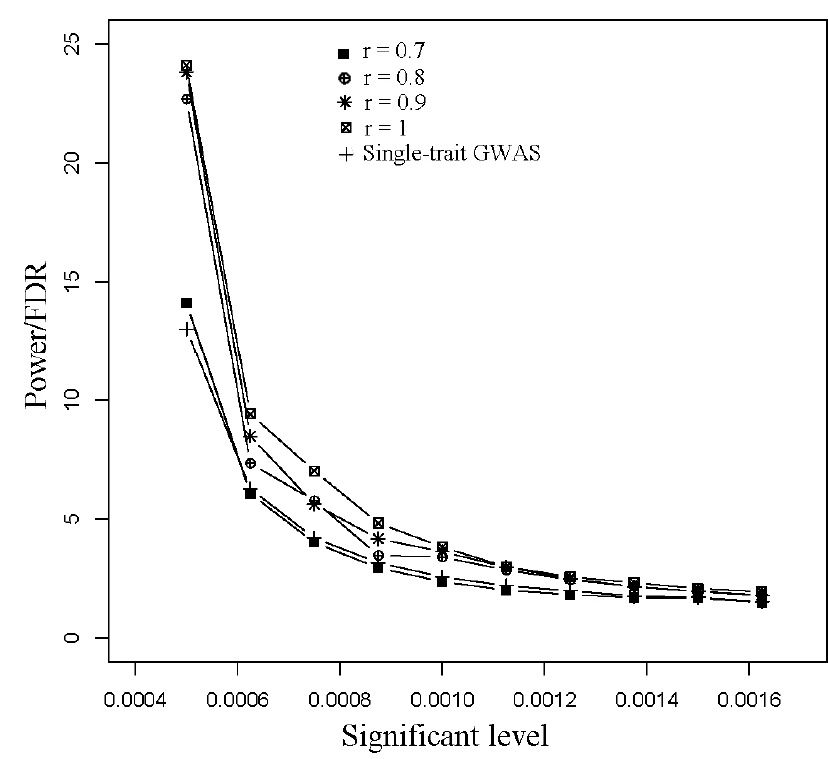
Figure 4. Comparison of power/ False Discover Rate (FDR) in different levels of linkage disequilibrium in the colocalizing effect model.